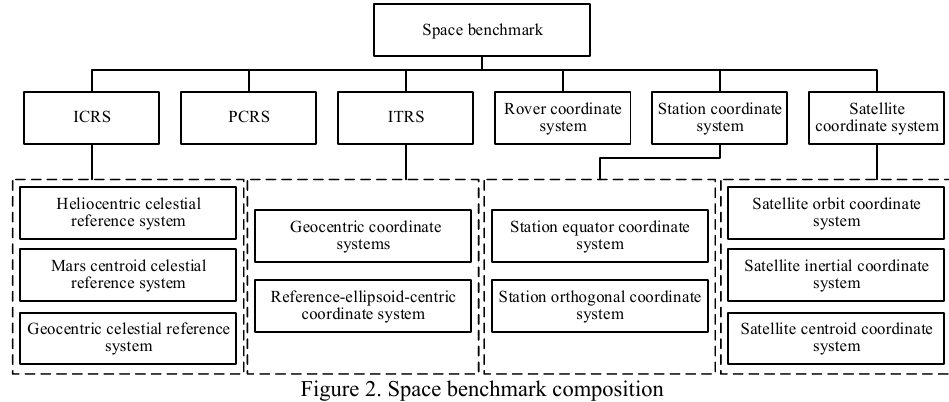
Figure 2. Space benchmark